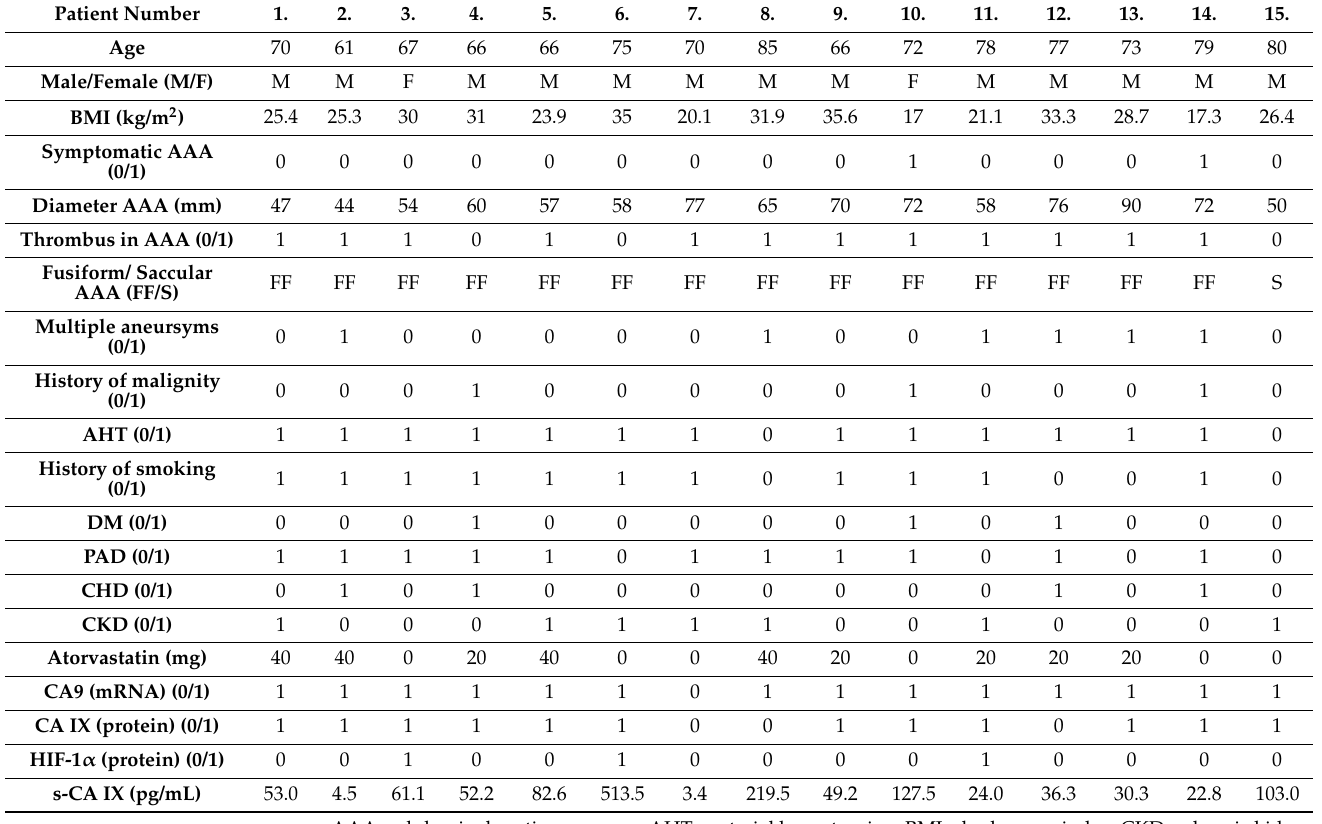
Table 3. Summary table with detailed information about patients: CA9 mRNA expression results, detection of CA IX and HIF-1 α proteins, and level of the soluble form of CA IX (s-CA